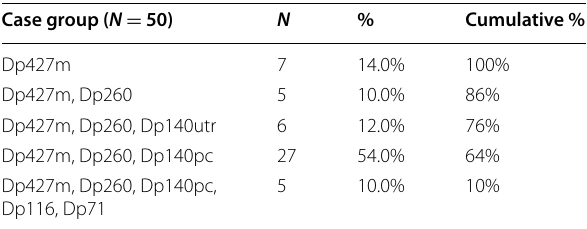
Table 6 Distribution of disrupted dystrophin gene isoforms in the case